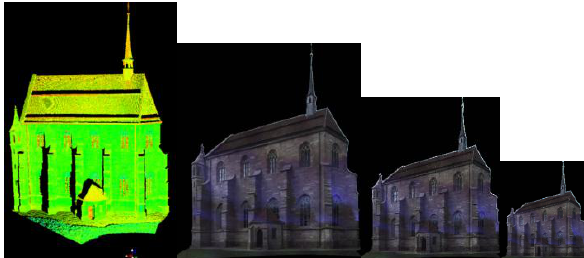
Figure 3. Lady Chapel dataset. From the left, 3D laser point cloud and generated RGB images with different pixel footprints; interval distance in object space (3, 8 and 13 cm)